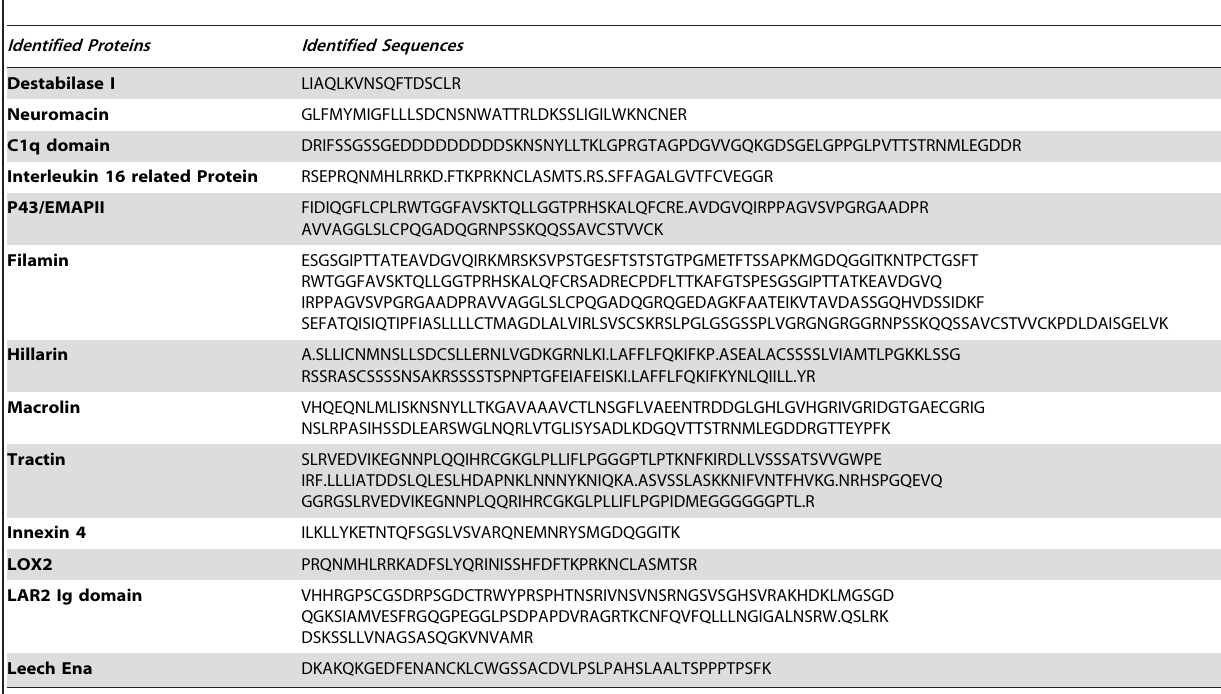
Table 1. Proteins detected in both regenerating adult nerve cord and in